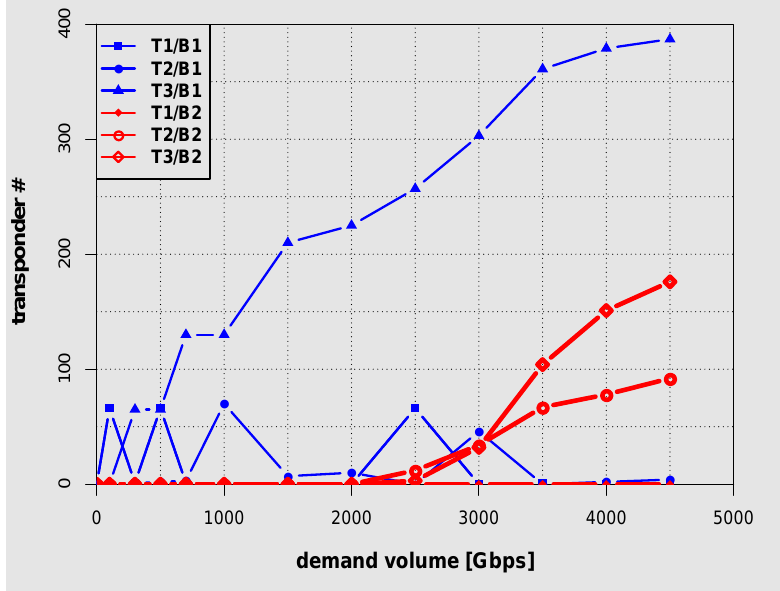
Figure 10. The dependence of number of transponders on the demand volume for Polish network.